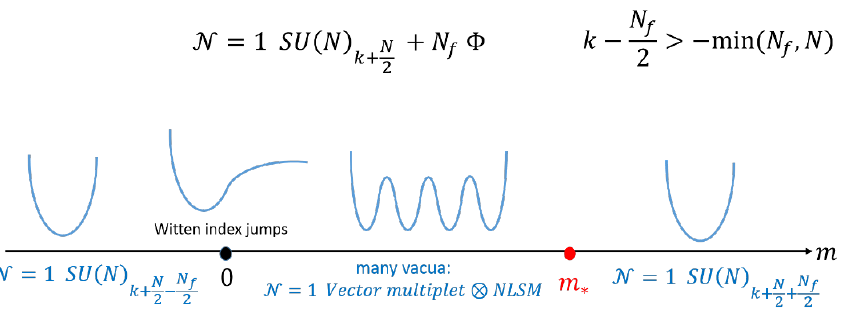
gauge theory coupled to a N f fundamental k + 1 N;k 2